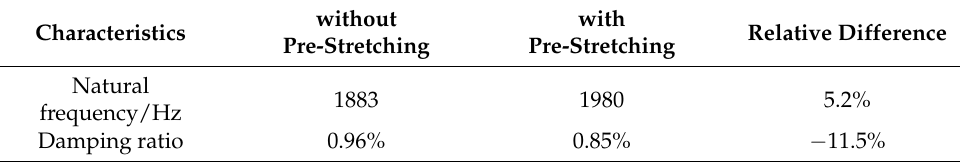
Figure 8. Acceleration FRFs of 7 excitation points for the MCMHTs: ( a ) without pre-stretching; ( b ) with pre-stretching. Table 5. Dynamic characteristics of the MCMHTs from the modal analysis module.